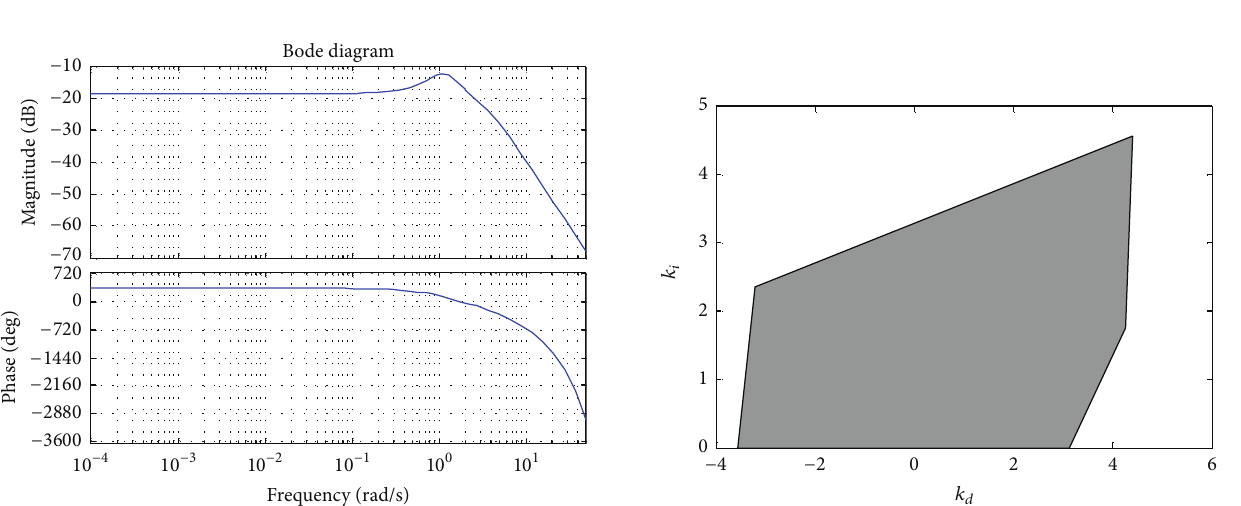
Figure 2: The Nyquist plot for Example 6.